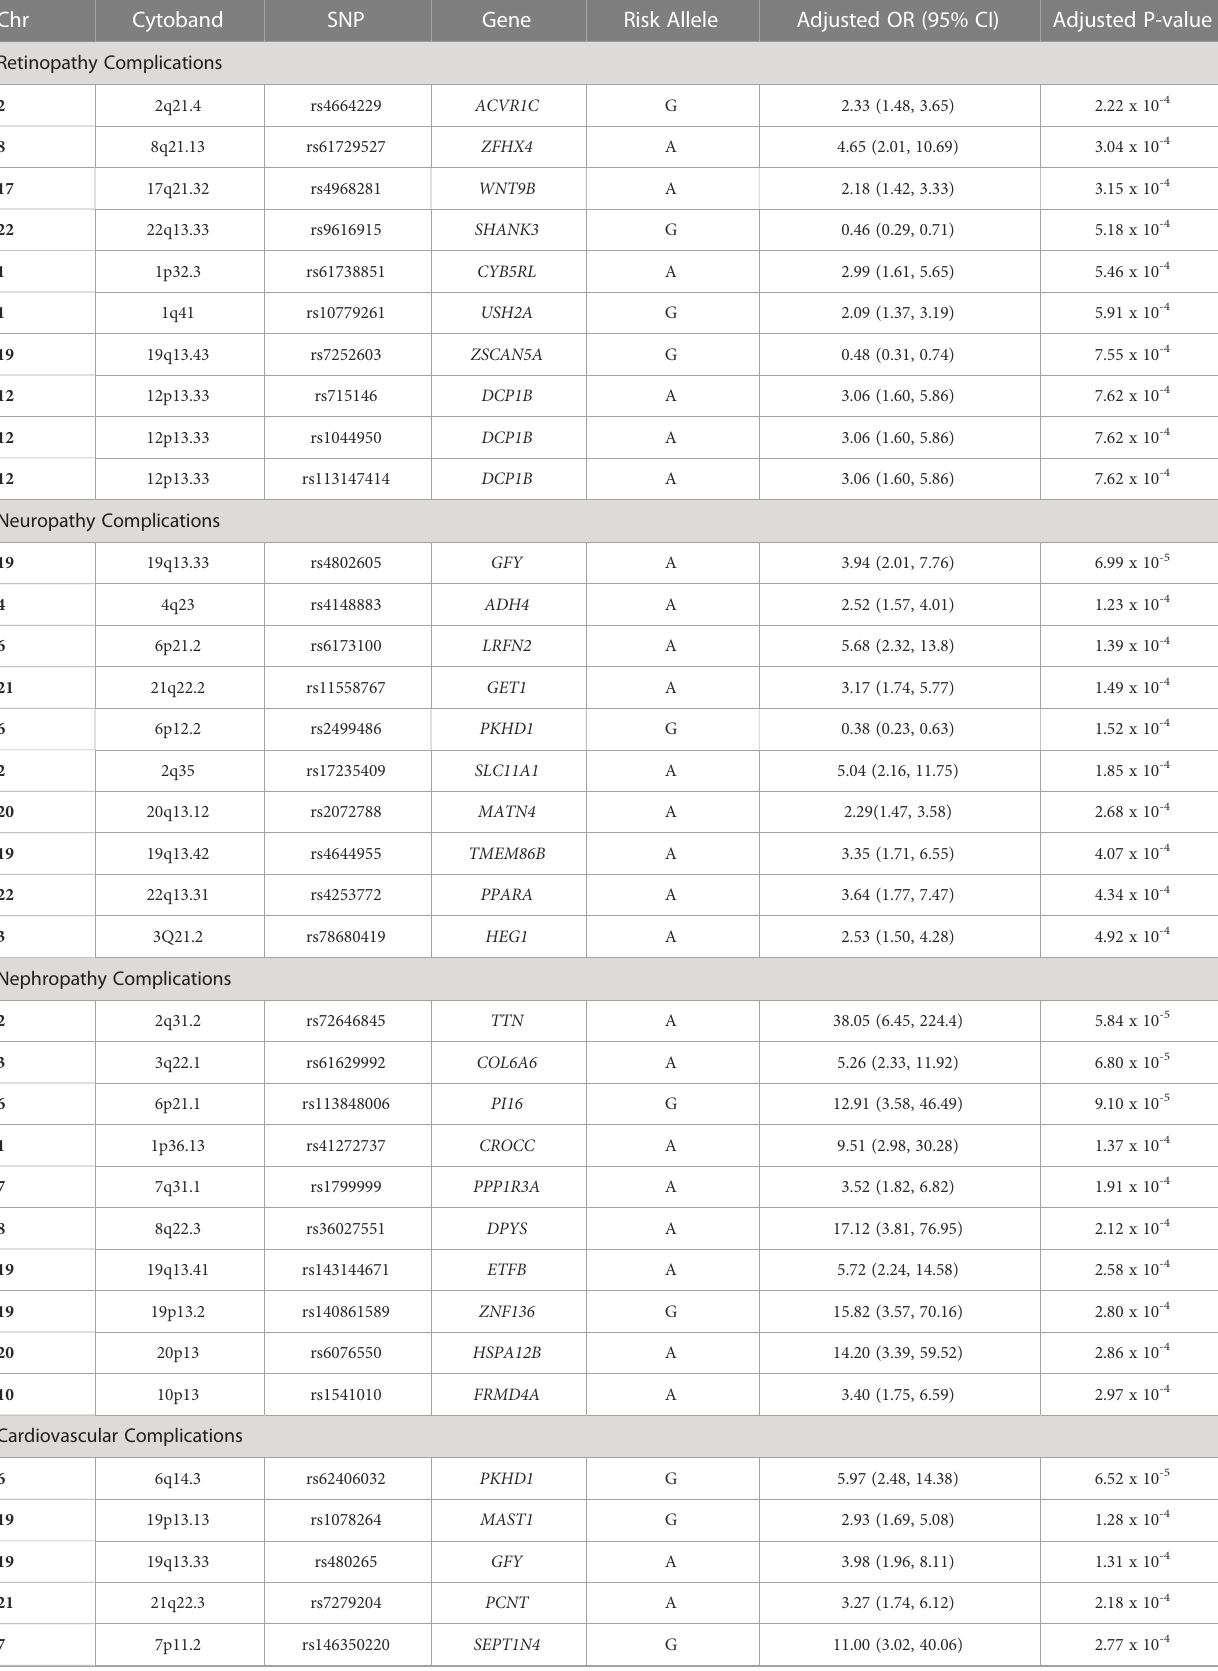
TABLE 2 Top 10 SNPs that were associated with each diabetes-related complication group in the Emirati